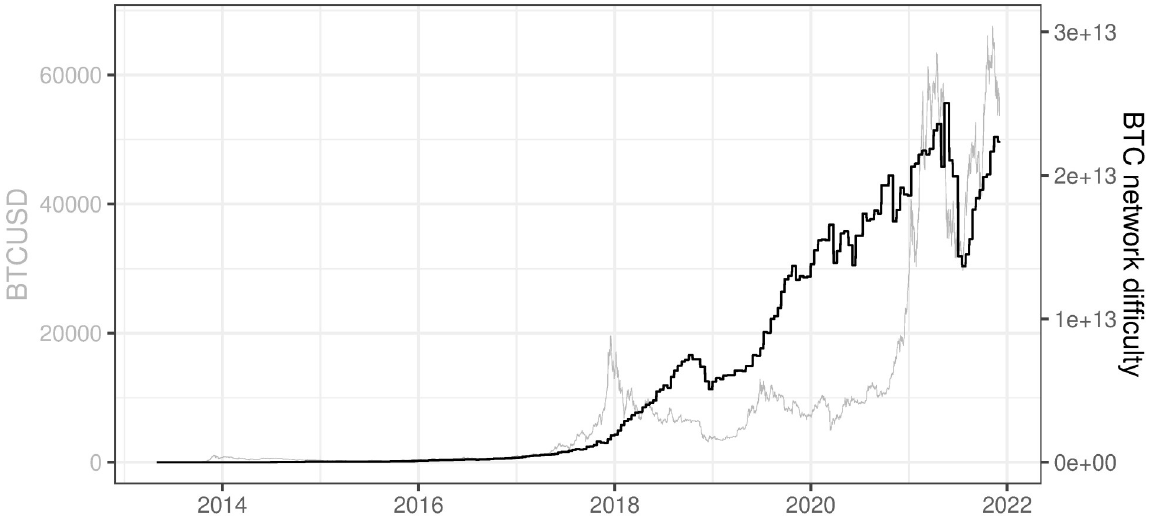
Fig 12. BTC network difficulty. Note: Data covers the period between 2013/05/01 to 2021/12/03. Source: https://charts.coinmetrics.io/network- data/.